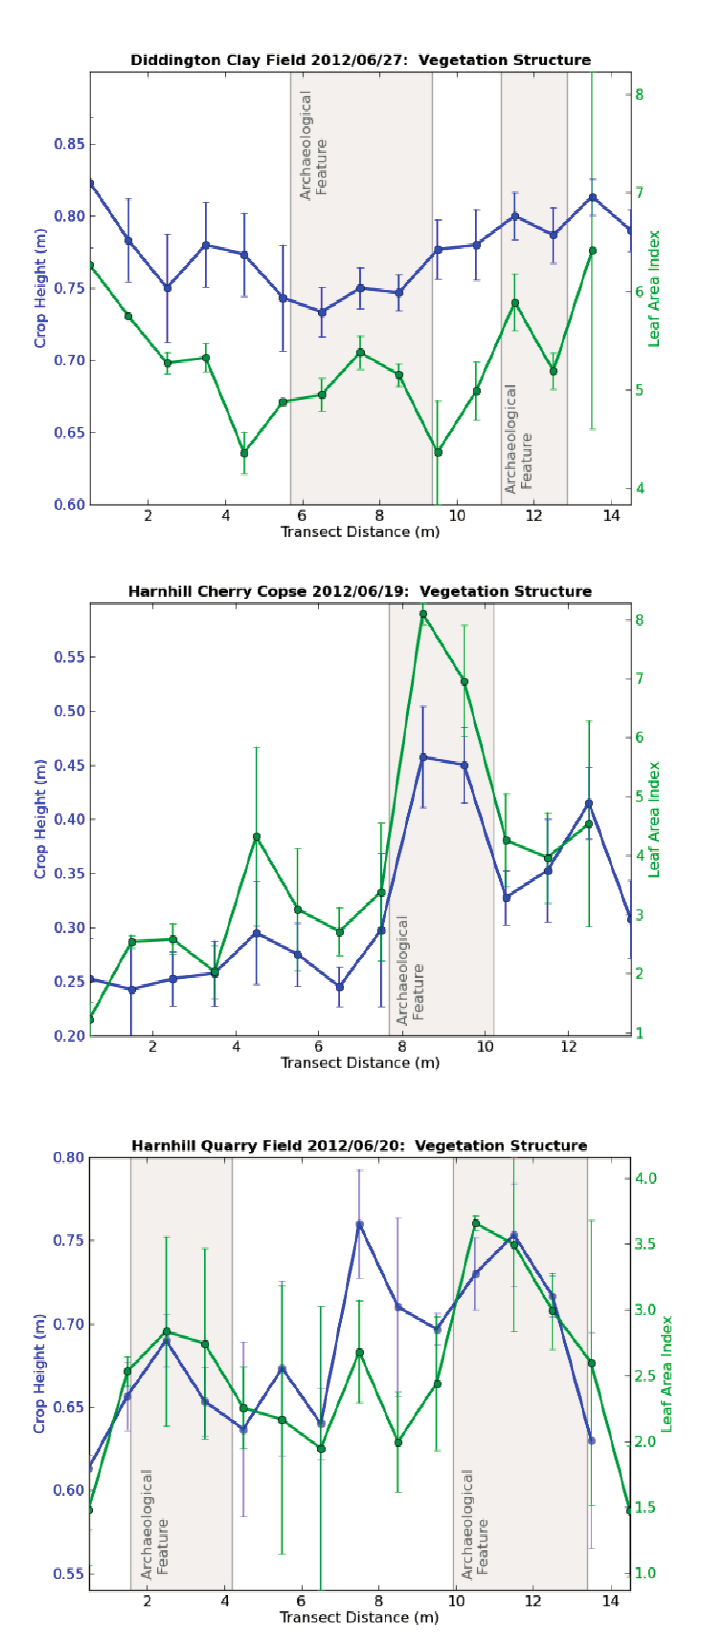
Figure 3. Profiles of vegetation height and LAI, June 2012 (mean and standard deviation). Note: no data available for DDT1 field as the crop was too dense and tall to